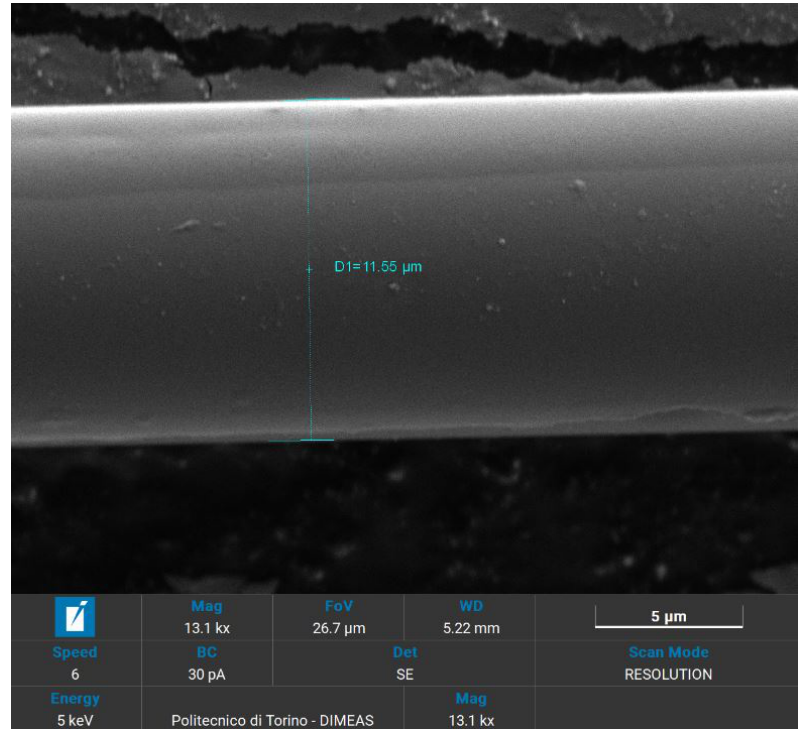
Figure 12. Lateral surface of virgin basalt single fiber.